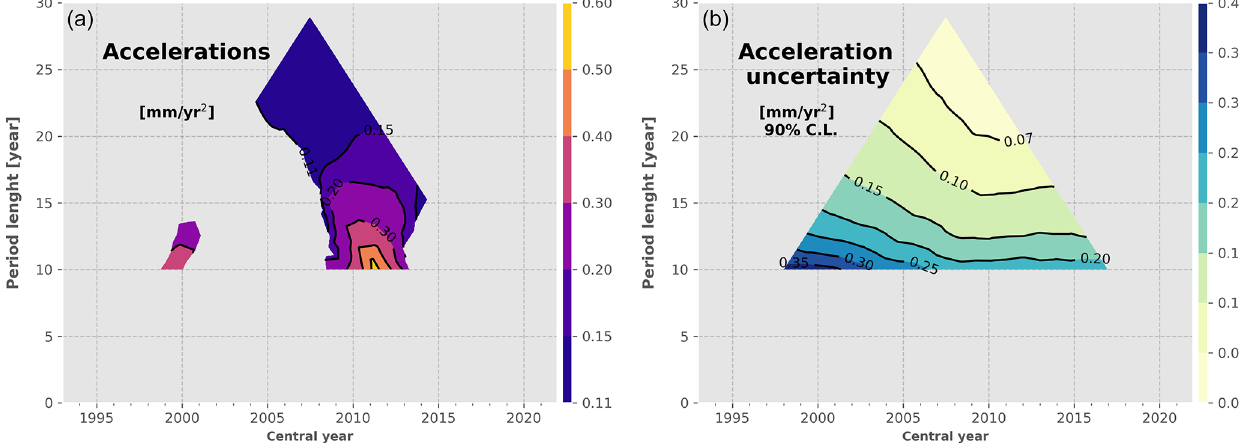
Figure 7. GMSL accelerations (a) and acceleration uncertainties (b) of the L2P21 product estimated for all period lengths between 10 years and the total altimetry record (January 1993 to October 2021). Only the significant values (i.e. above uncertainties) are shown. The x axis corresponds to the central year of the considered period ( y axis). The uncertainties are shown at the 90% confidence level.